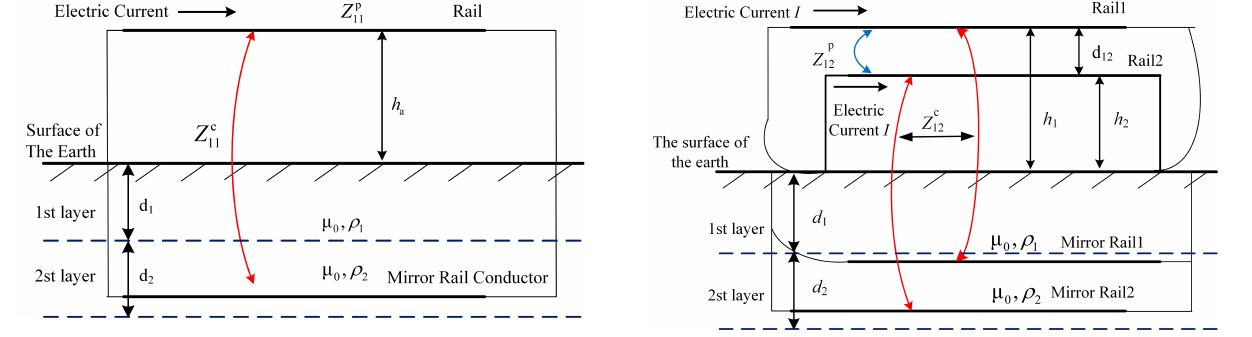
Fig. 3. Calculation model of rail mutual